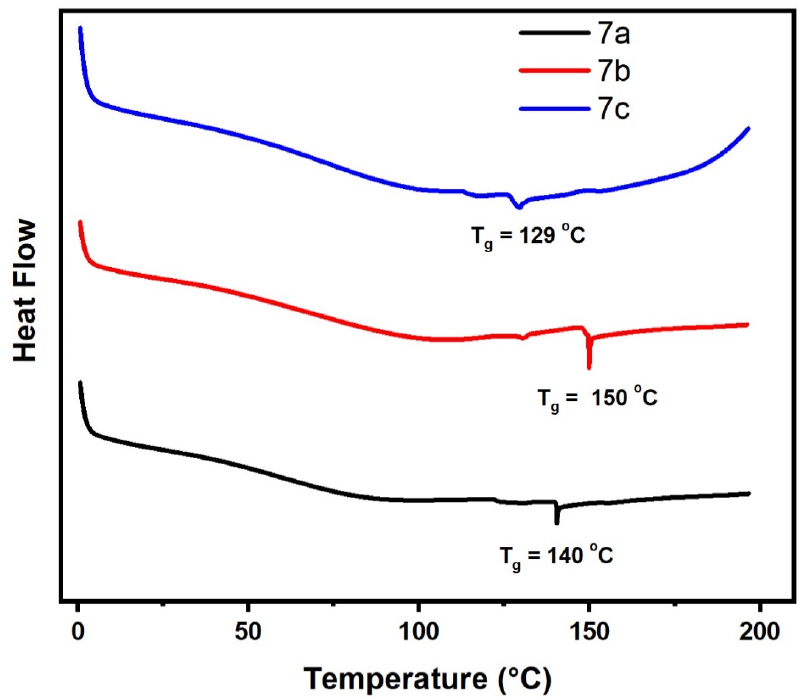
Figure 9. Differential scanning calorimetry (DSC) of samples (7a-c).